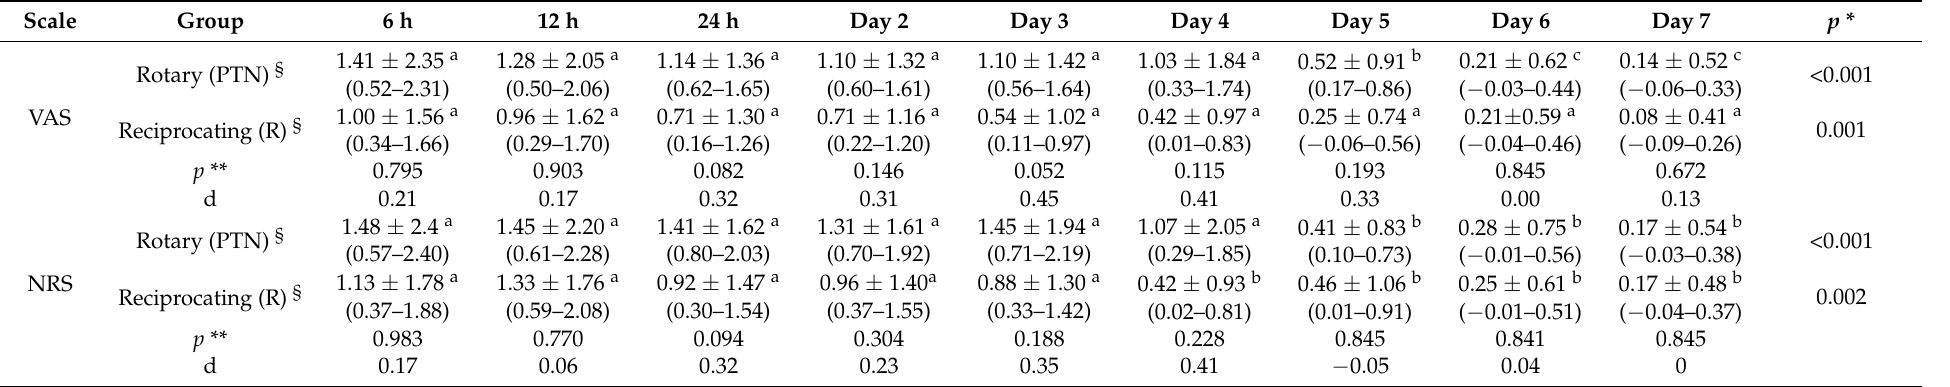
* Intra-group comparison of all evaluated time intervals—Friedman test. § Comparison by pairs in each group—Wilcoxon test with Bonferroni correction ( p < 0.006). a,b,c For each group, mean scores indicated by the superscript lowercase letters in same line are statistically different. The comparison was performed between pairs: 6–12 h; 12–24 h; 24 h–2 days; 2–3